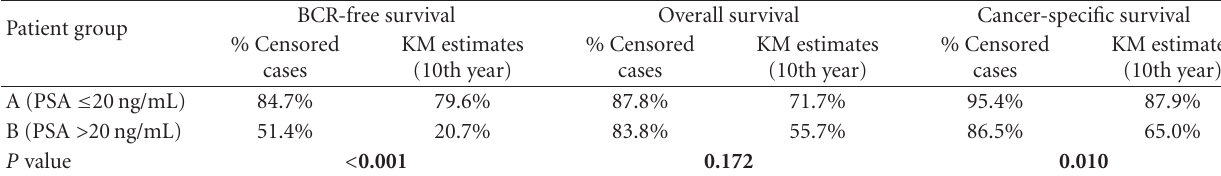
Table 3: Oncological outcome at the 10th year after